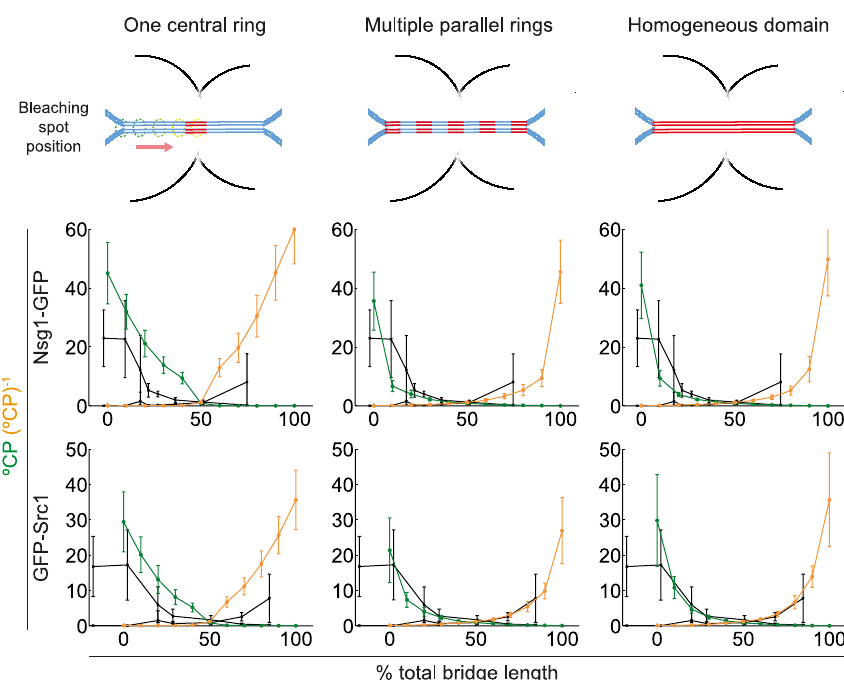
Figure 5. Comparing diffusion barrier scenarios constituted by different specialised lipid domain configurations in LA. u CP (green) and u CP 2 1 (orange) ratios of Nsg1-GFP and GFP-Src1 plotted against the position of the bleaching spot relative to the bridge length (starting at the junction between the mother lobe and the bridge, ending where the latter joins the daughter lobe). P in values were fixed as in Table 1. Experimental data (black) reconstructed from Fig. 4C in [2].